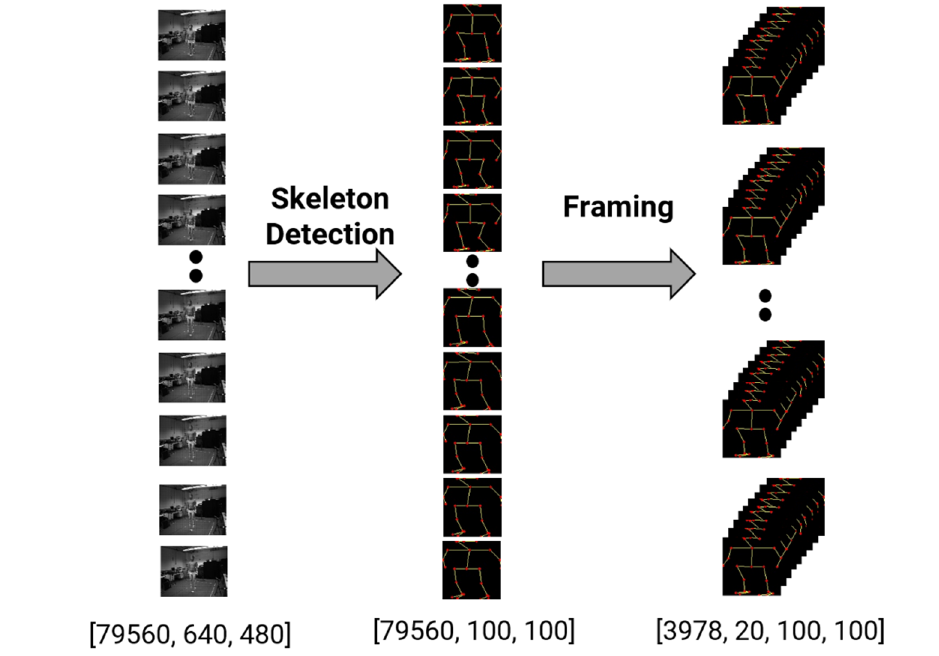
Figure 2. Skeleton i mage input data for deep learning.